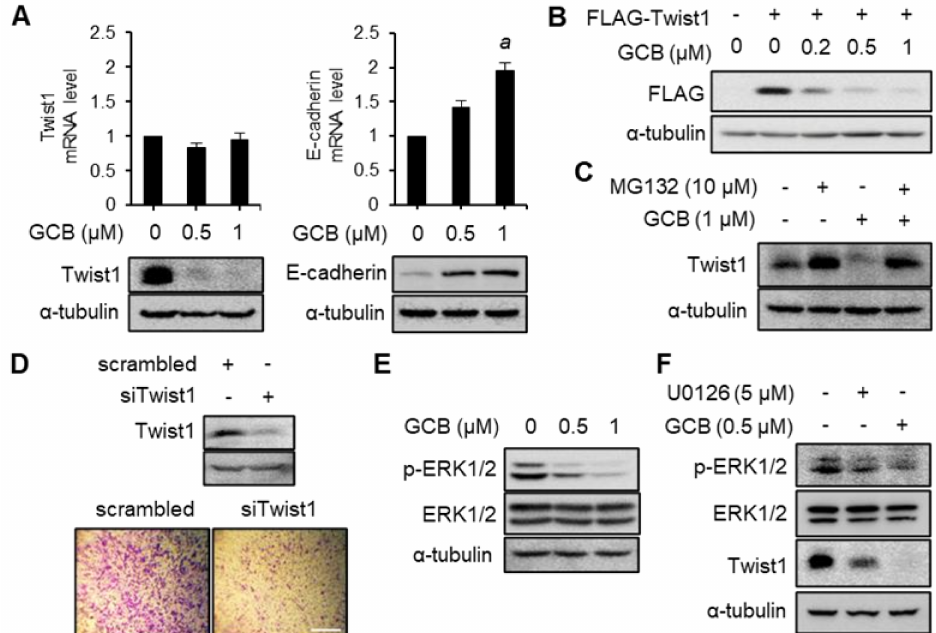
Figure 4. GCB treatment regulated ERK signaling and Twist1 levels. ( A ) After 24 h of incubation with GCB (0, 0.5 and 1 µ M), total cell lysates were analyzed by immunoblotting (bottom panels) and qRT-PCR (top panels) for assessing the expression levels of Twist1 and E-cadherin. The mRNA expression levels of Twist1 and E-cadherin were measured and normalized using the GAPDH gene. The expression levels of Twist1, E-cadherin, and α -tubulin proteins were assessed using specific antibodies. Values are expressed as the mean ± SEM (n = 3). Data were analyzed by one-way ANOVA; a p < 0.05 relative to the GCB-untreated control. ( B ) FLAG-tagged Twist1 was overexpressed in Hep3B cells; the cells were then treated with GCB for 24 h. The expression level of Twist1 was assessed using specific antibodies. ( C ) Huh7 cells were pretreated with MG132 for 6 h and then treated with both GCB and MG132 for additional 3 h. The expression levels of Twist1 and α -tubulin proteins were assessed using specific antibodies. ( D ) Hep3B cells were transfected with siTwist1 or scrambled (control) siRNA, and the migratory activity was evaluated using transwell migration assays. Images were taken 24 h after the cells were seeded in the upper chamber (scale bars, 0.5 mm). ( E ) Huh7 cells were treated with GCB (0, 0.5, and 1 µ M) for 24 h. Total cell lysates were separated by SDS–PAGE. The levels of p-ERK (Thr202/Tyr204), ERK, and α -tubulin proteins were assessed using specific antibodies. ( F ) Proteins expressed in cells treated with U0126 and GCB for 24 h were separated by SDS–PAGE, and the levels of p-ERK, ERK, Twist1, and α -tubulin proteins were detected using specific